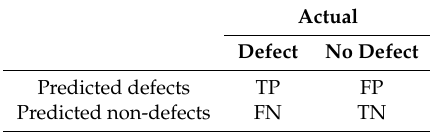
Table 1. Confusion matrix.